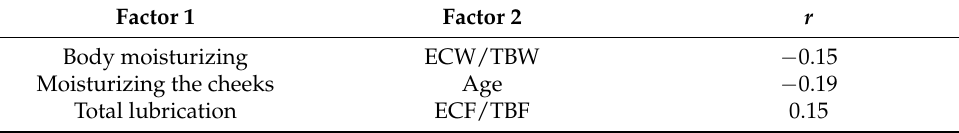
Table 6. Correlations between skin hydration, lubrication and body composition ( p < 0.05). Factor 1 Body